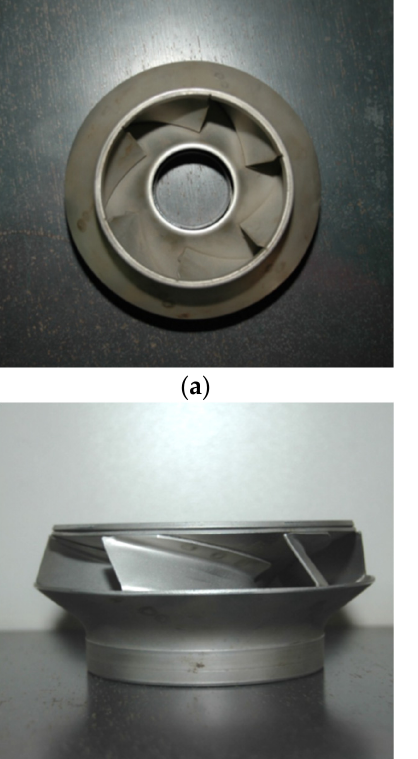
Table 1. Main dimensions of the impeller of the SP 215 pump measured by adopting the traditional measuring instruments (i.e., caliper and micrometer). For the visualization of the dimensions refer to Figure